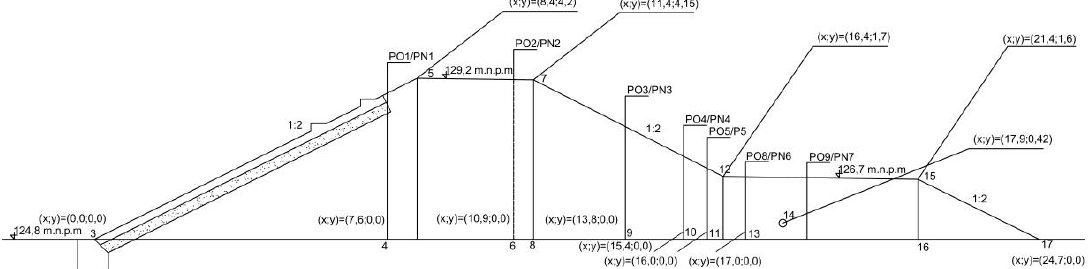
Figure 2. Earth dam constructions and parameters.